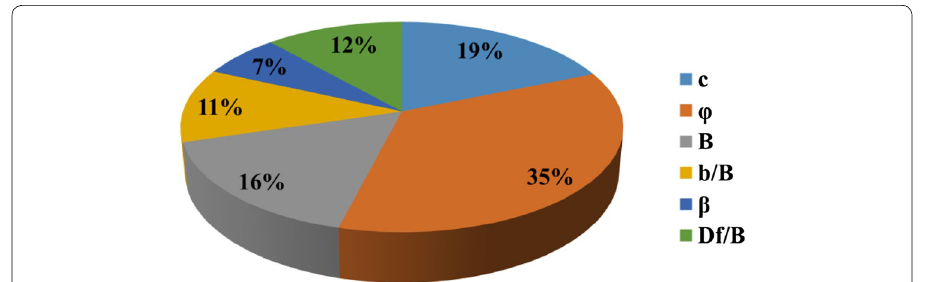
Fig. 19 Relative importance of the parameters according to Garson’s algorithm